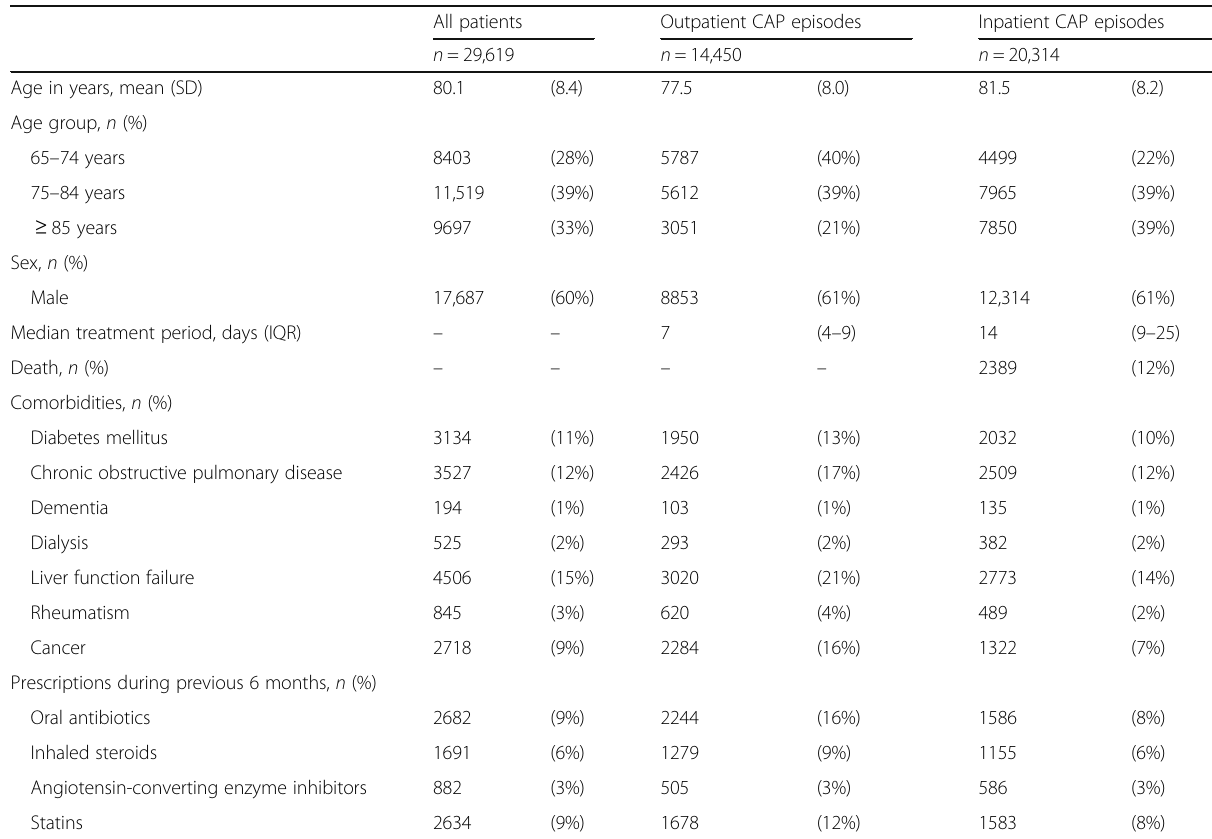
Table 1 Patient characteristics